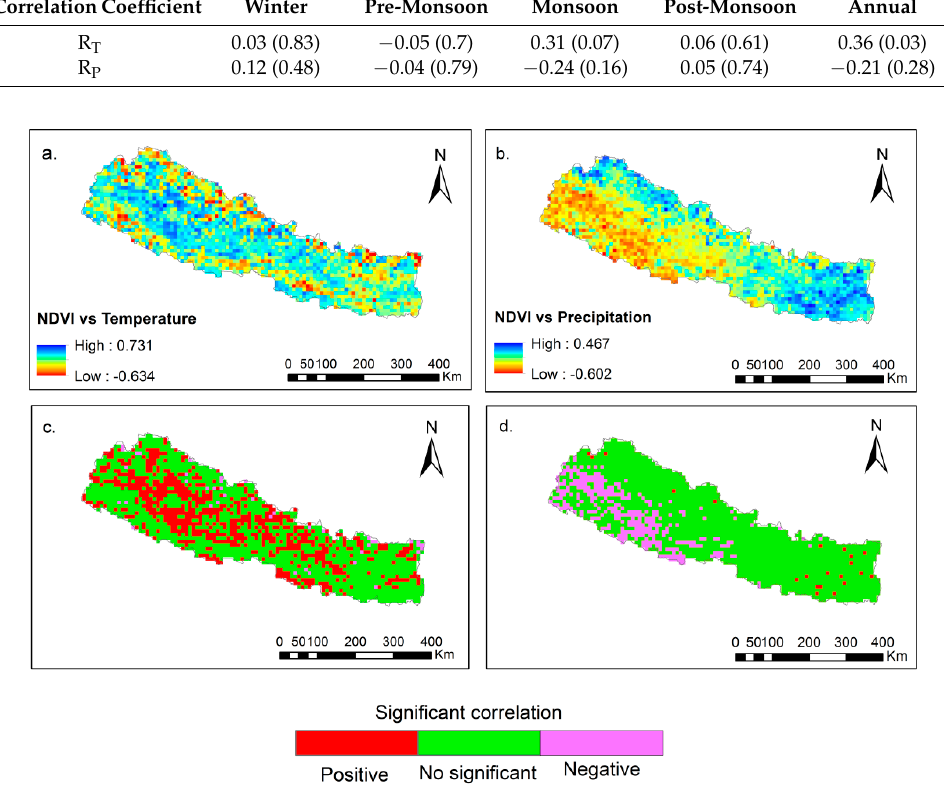
Figure 5. Spatial and temporal correlation between: ( a ) NDVI and temperature (R T ); ( b ) NDVI and precipitation (R P ); ( c ) significant correlation between NDVI and temperature; ( d ) significant correlation between NDVI and precipitation in Nepal, 1982–2015.